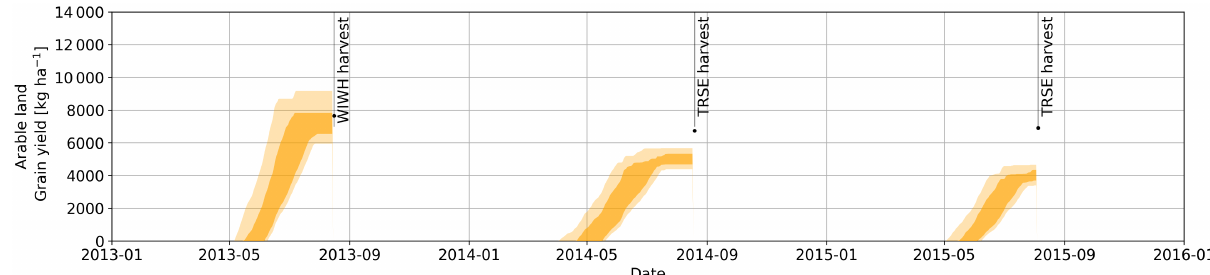
Figure A4. Modelled dry weight grain yield on arable land use. WIWH, winter wheat; TRSE, Triticum secale . RMSEs ranging from 1125.7 to 2529.2kgha − 1